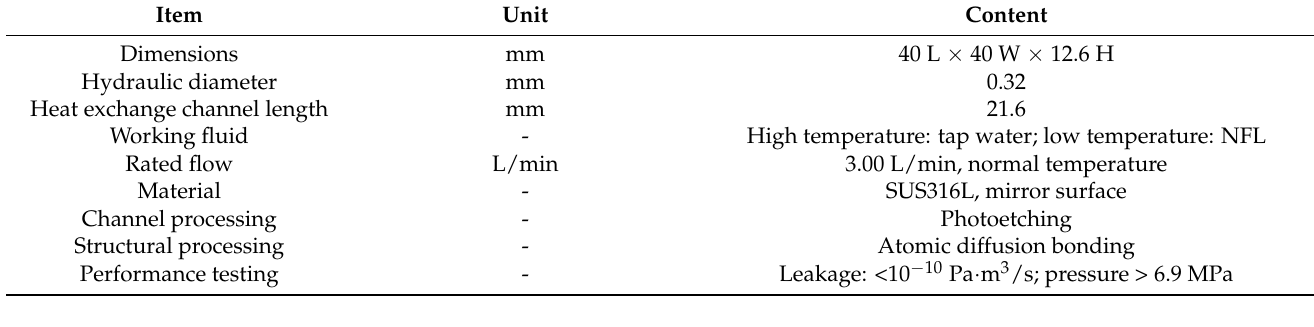
Table 1. Sizes, materials, and working fluid of compact heat exchanger.